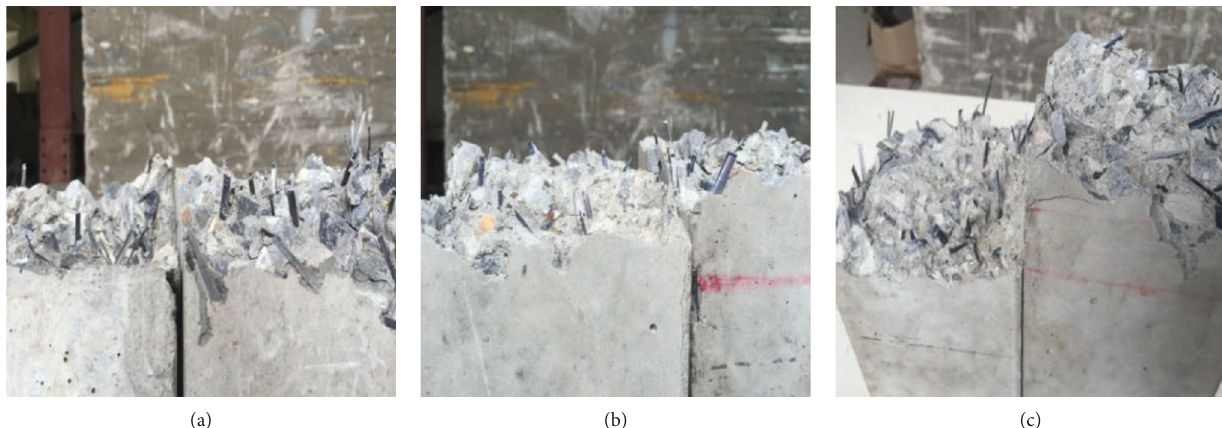
Figure 13: Cross section of a randomly distributed steel fibre-reinforced concrete beam. (a) Number 1a. (b) Number 1b. (c) Number